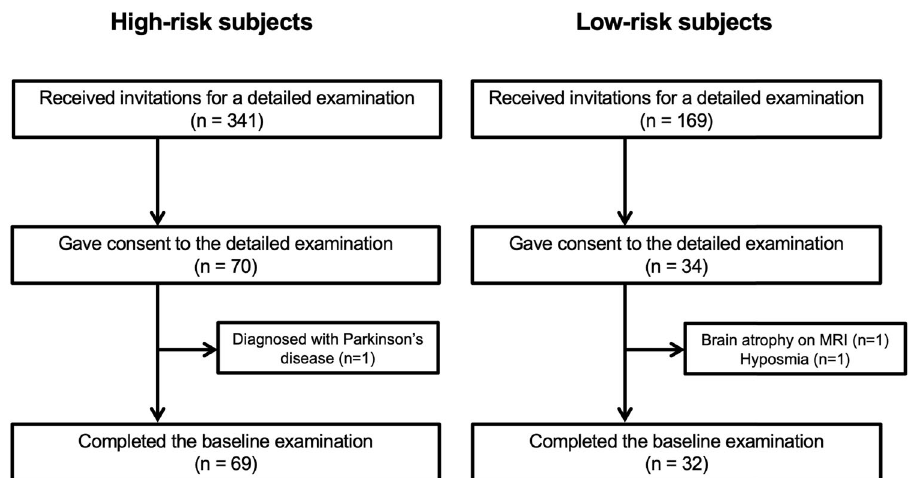
Fig. 1 Participant fl owchart of this study. We screened health checkup examinees to identify potential participants using the following questionnaires: SCOPA-AUT the Japanese version of the Scale for Outcomes in Parkinson ’ s disease for Autonomic Symptoms, SAOQ Self- administered Odor Question, RBDSQ REM behavior disorder screening scale, BDI-II Beck Depression Inventory-Second Edition, ESS Epworth Sleepiness Scale, and PASE Physical Activity Scale for the Elderly. We classi fi ed subjects who were ≥ 50 years old and had ≥ 2 abnormal scores in the SCOPA-AUT, SAOQ, and RBDSQ into the high-risk group. The cut-off value for identifying the high-risk group was 10 for SCOPA-AUT, 90.0% for SAOQ, and 5 for RBDSQ. Subjects who were ≥ 50 years old and had no abnormalities in all the questionnaires were classi fi ed into the low- risk